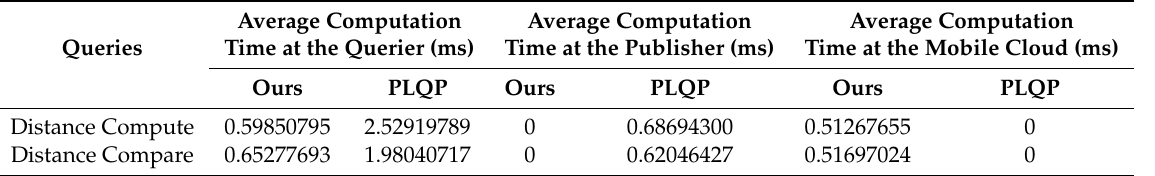
Figure 9. The time comparison of performing location distance compare between our scheme and PLQP. Table 2. The computation cost